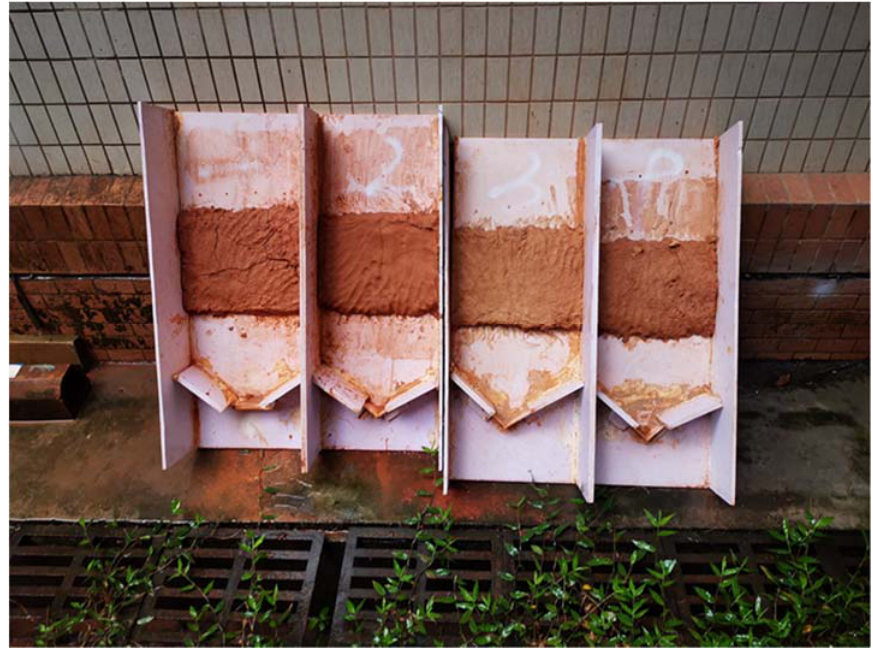
Figure 3. The simulated adjustable slope. Table 4. Slope classification by inclination.